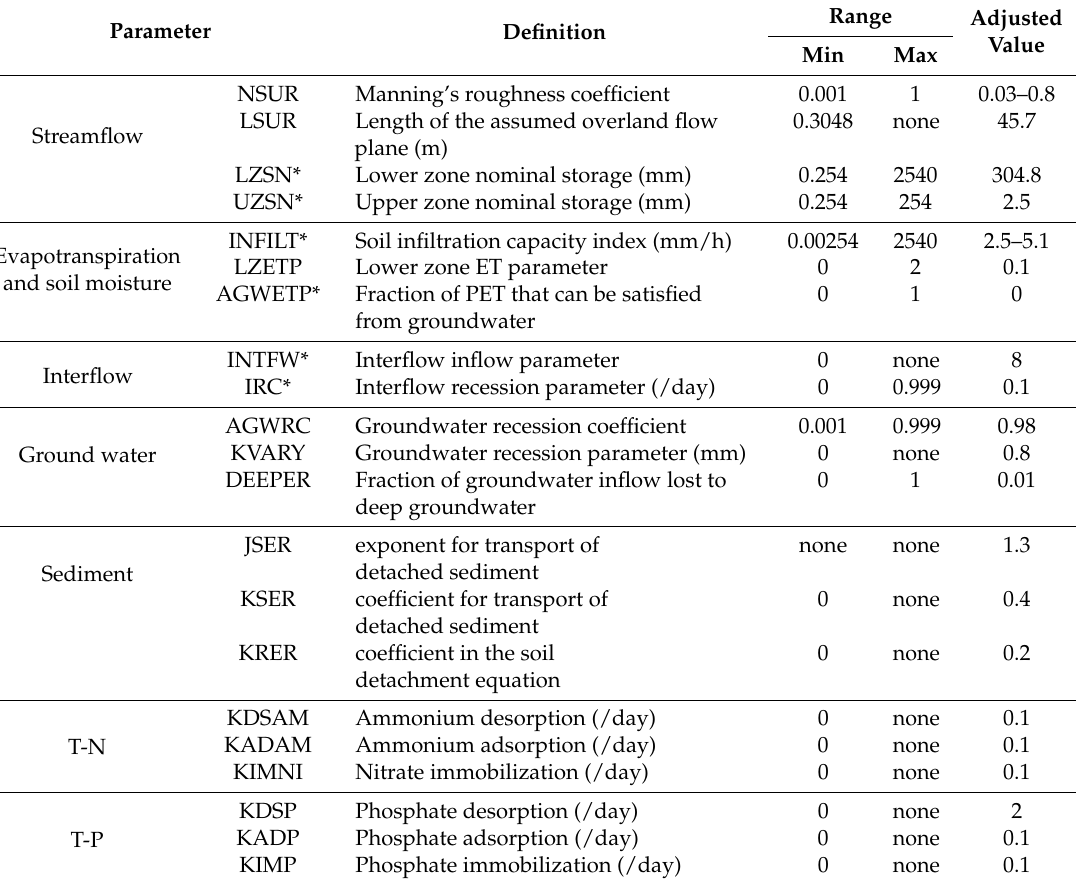
Table 1. Calibrated parameters of the HSPF